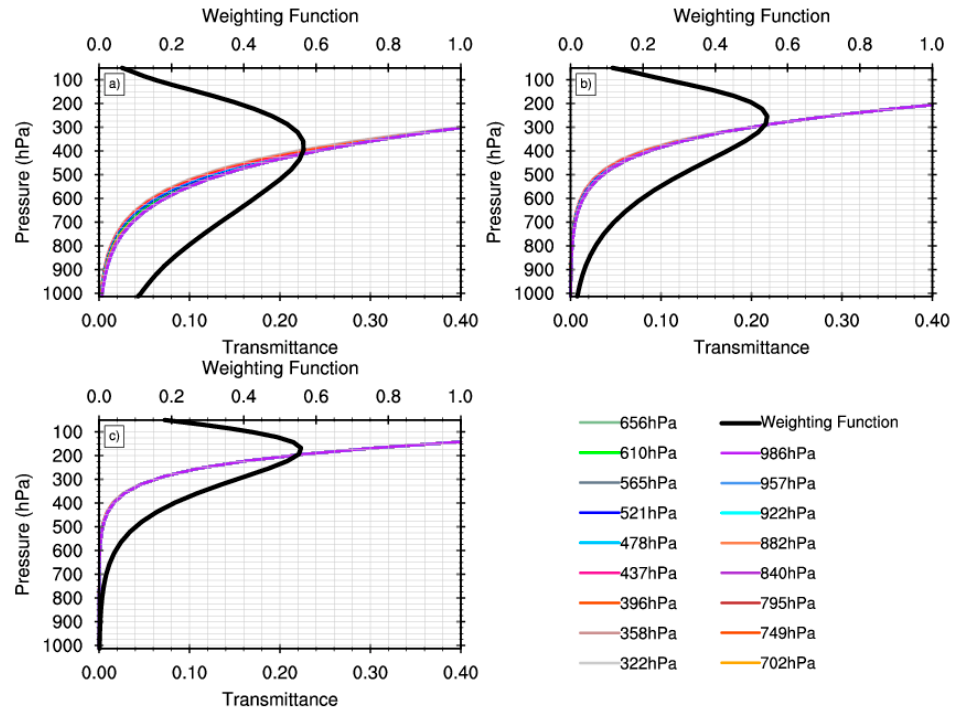
Figure 3. Transmittance at (a) 54.4 GHz, (b) 54.94 GHz and (c) 55.5 GHz considering CLW absorption. The top varies among the CLW profiles from 322 to 986 hPa, and the bottom of the cloud is set to the surface. The transmittance of different channels changes as the height of CLW varies.